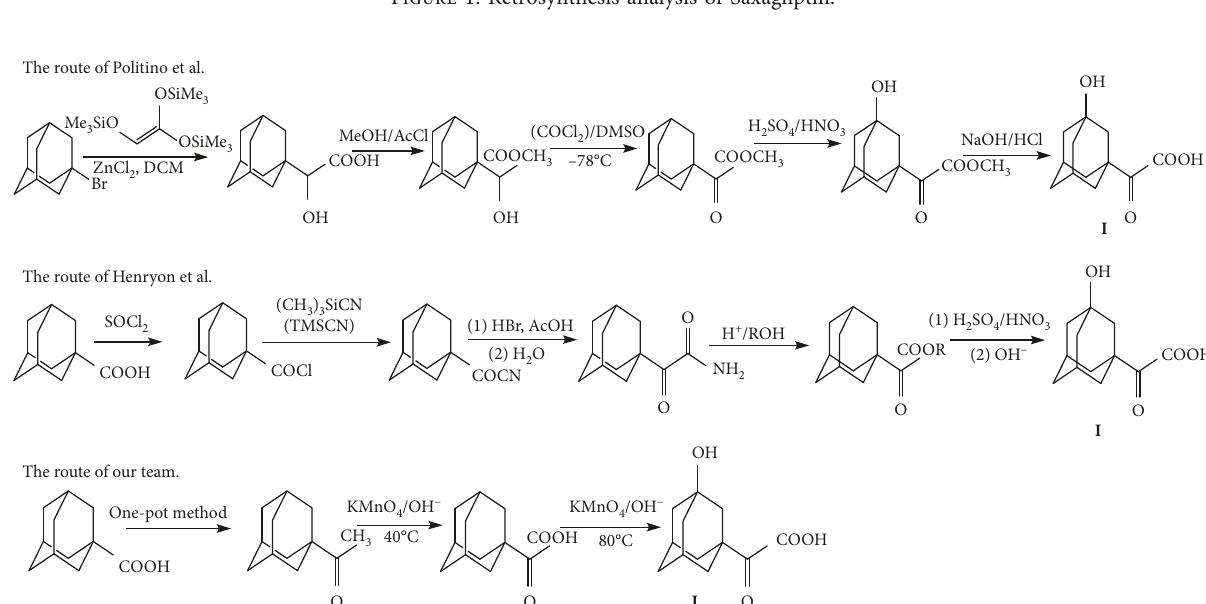
Figure 2: The existing methods to synthesize I